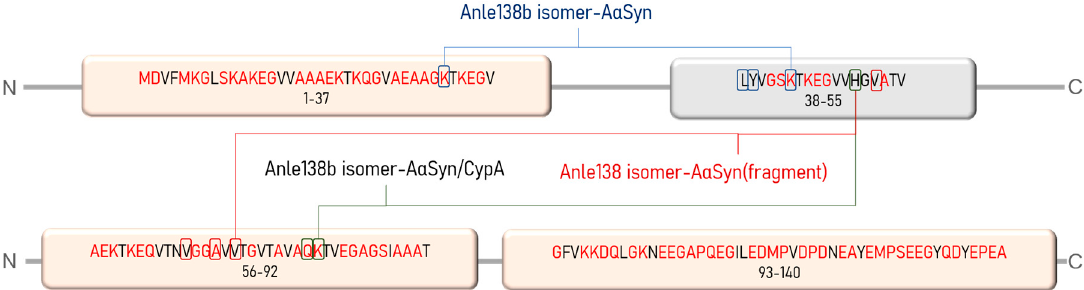
Figure 11. Amino acid sequence of A α Syn. Disorder-promoting amino acid residues are marked in red; pink blocks reflect clusters rich in disorder-promoting residues. Rectangles mark amino acid residues involved in the stabilization of the Anle138b isomer–A α Syn and Anle138b isomer–A α Syn– CypA complexes (according to molecular docking data).